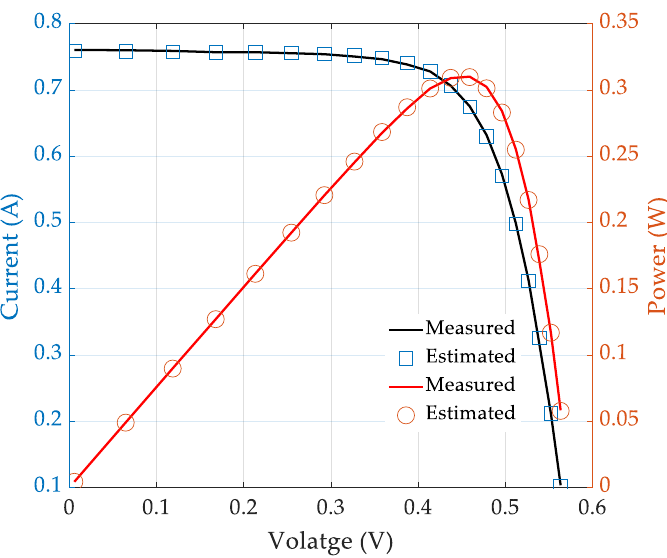
Figure 4. I-V and P-V characteristics curve for estimated and experimental values for double-diode model of R.T.C France solar cell.